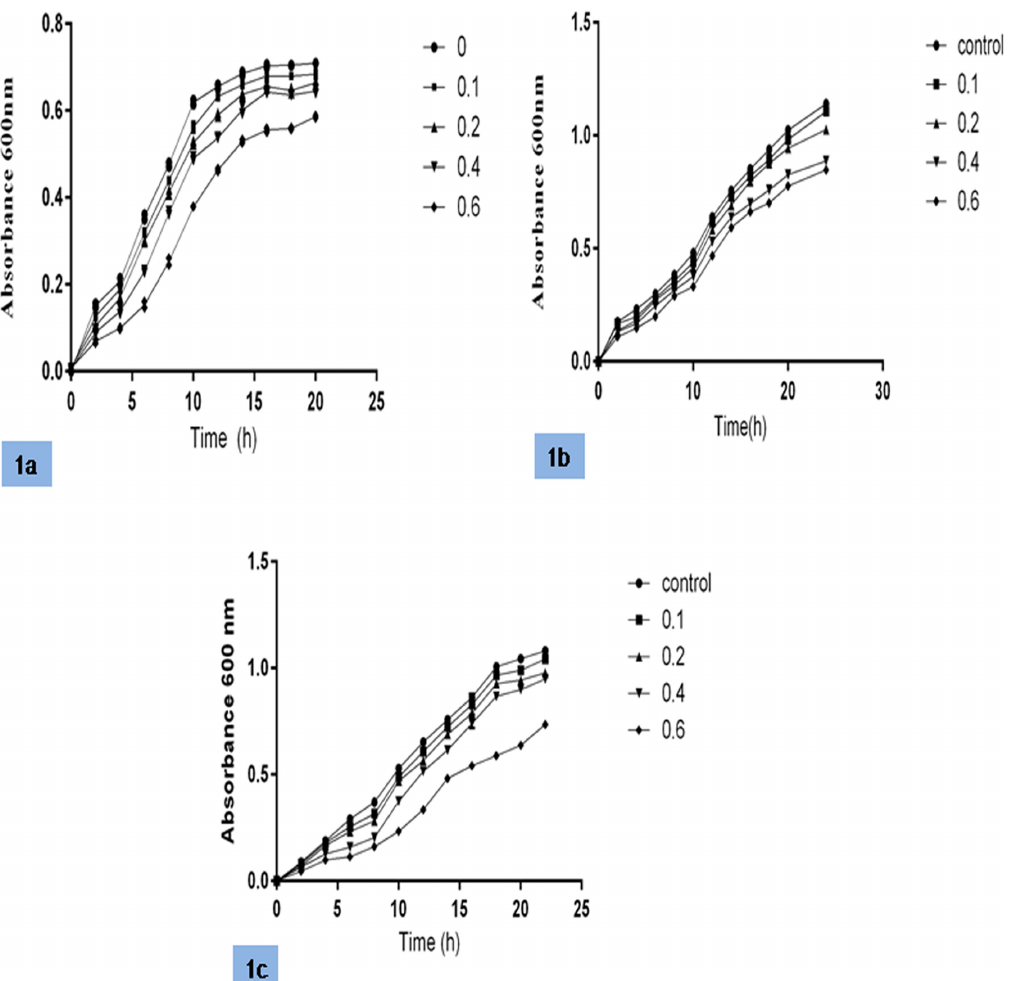
Fig 1. Growth curves of P . aeruginosa PAO1 (1a), C . violaceum CV026 (1b) and E coli pJN105LpSC11 (1c) at a sub-lethal concentration of cinnamon oil, plotted with respect to the controls (no cinnamon oil).